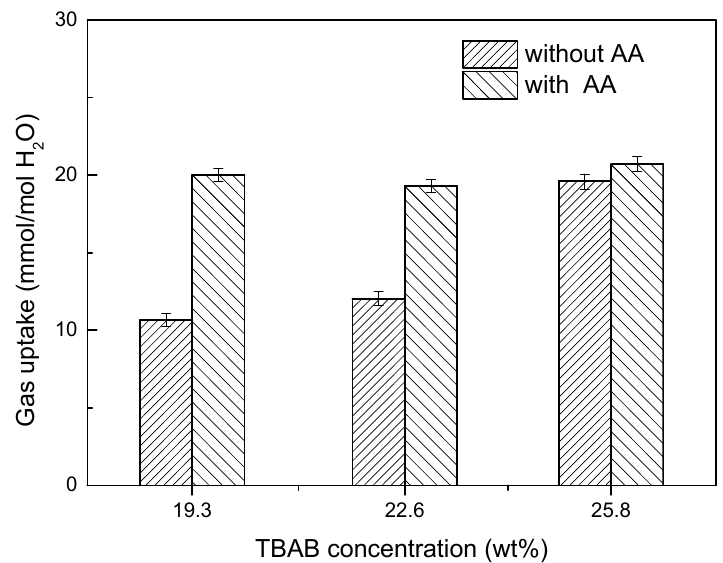
Figure 6. Gas storage capacity in different conditions.